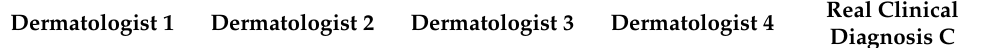
Table 1. Results of the descriptive analysis separated for the three different instruments and for the four dermatologists. Absolute and % values are reported. Instrument F: dermatoscope; Instrument N: Nurugo; Instrument V: Nurugo in epiluminescence setting with slide; C: real clinical